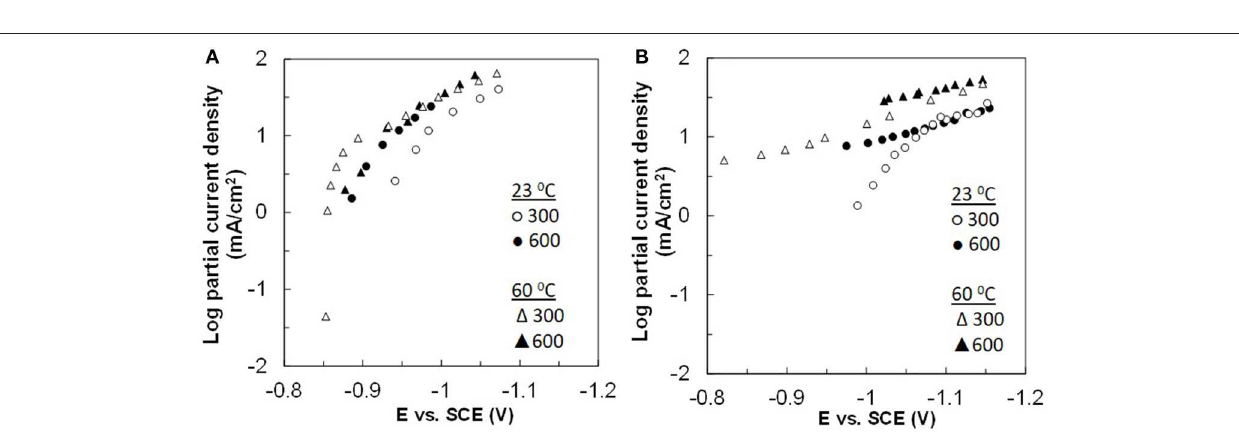
FIGURE 8 | Partial current densities of the side reaction for (A) Co–W and (B) Fe–Co–W deposition at two different temperatures of 23 and 60 ◦ C, and at electrode rotation rates of 300 and 600 rpm.